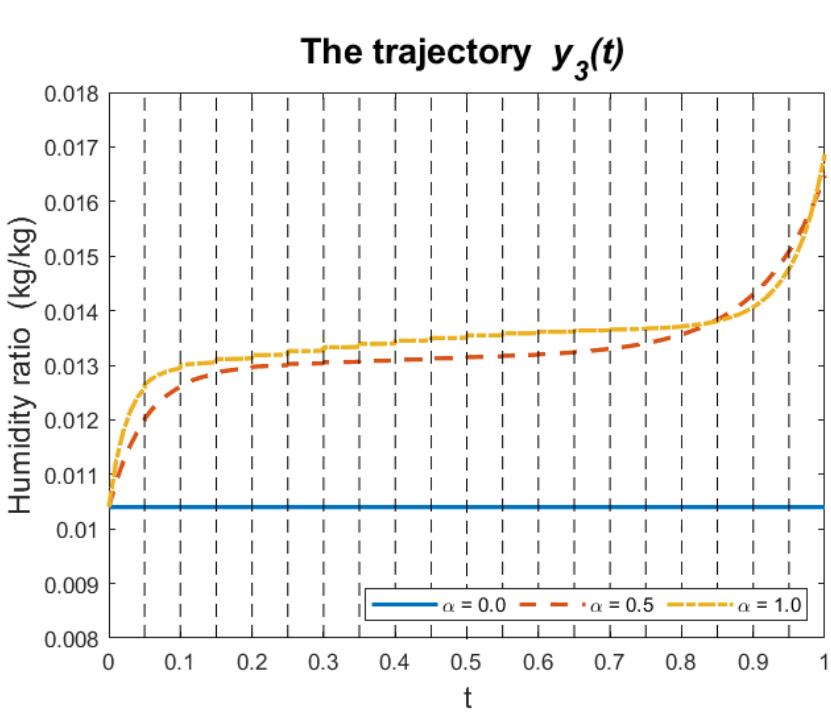
Figure 3. The trajectory of the state variable y 3 ( t )